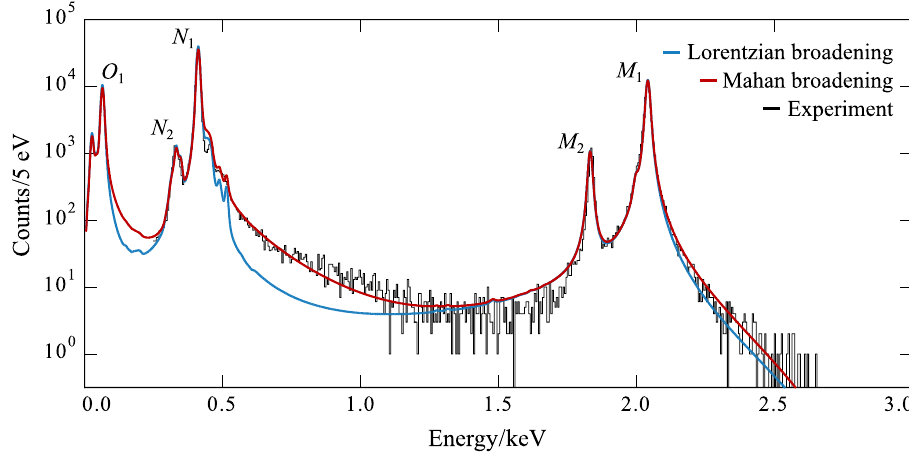
Fig. 2 Measured 163 Ho nuclear decay spectrum (black) compared to ab initio theory broadened using a Lorentzian line-shape (blue) and Mahan line-shape